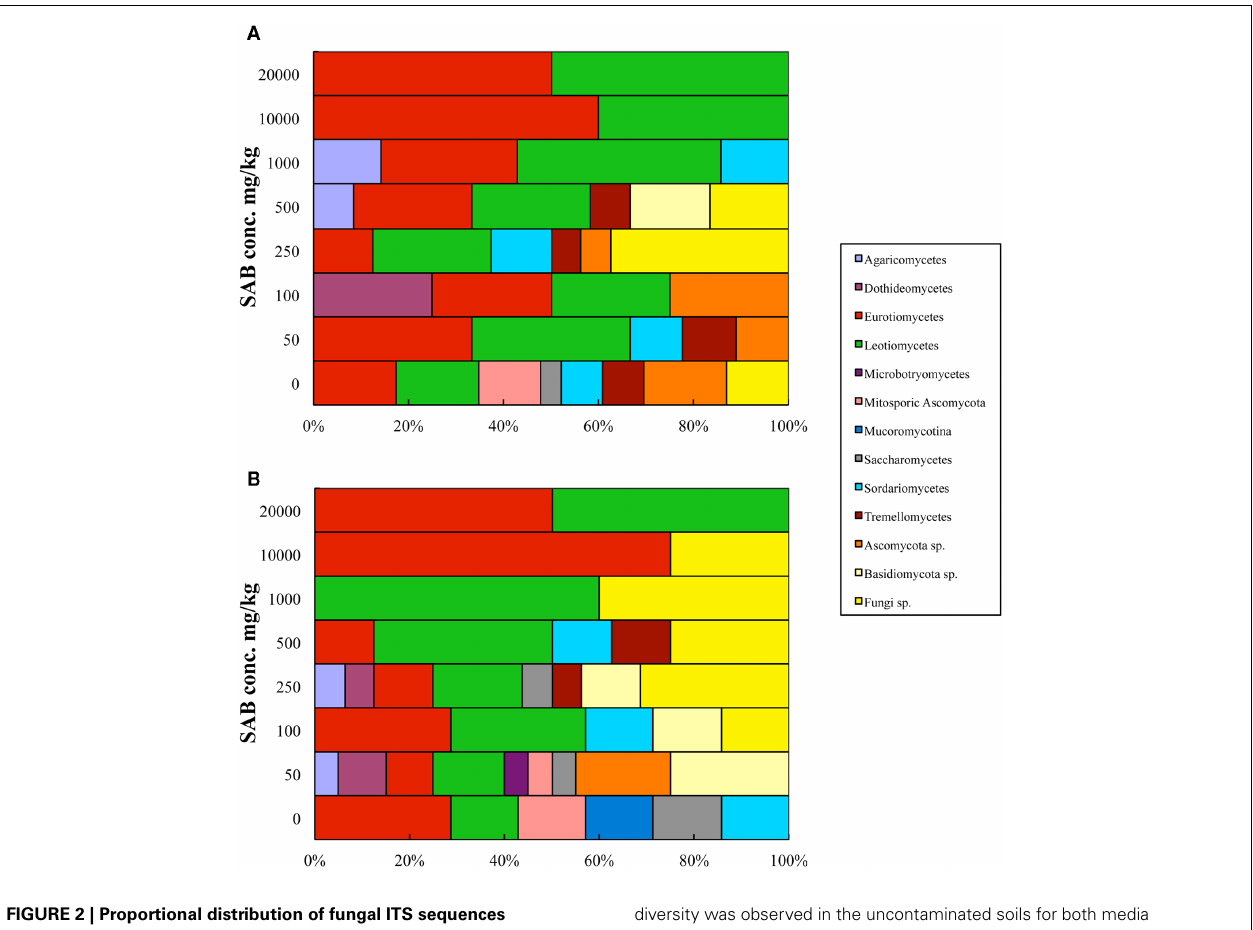
FIGURE 2 | Proportional distribution of fungal ITS sequences at the Class-level isolated from a range of SAB diesel fuel spiked soil samples. (A) The distribution of OTUs recovered on high nutrient media. (B) The distribution of OTUs recovered on low nutrient media.The fungal diversity recovered changed significantly as the concentration of SAB diesel fuel increased.The greatest level of